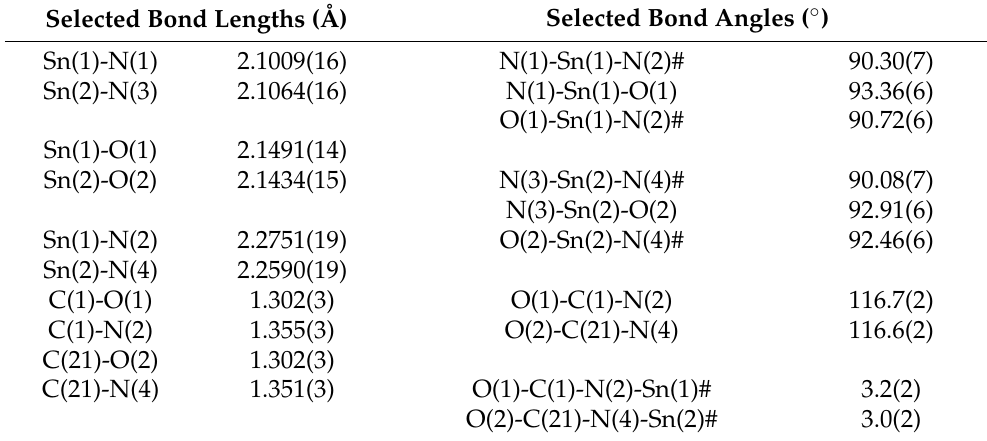
Table 2. Selected bond lengths (Å) and bond angles ( ◦ ) for complex 1 . Symmetry-generated atoms are marked with (#).